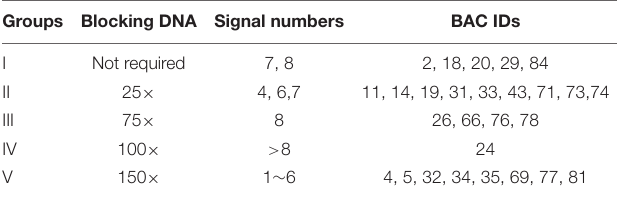
TABLE 1 | The classification of 27 positive clones with blocking